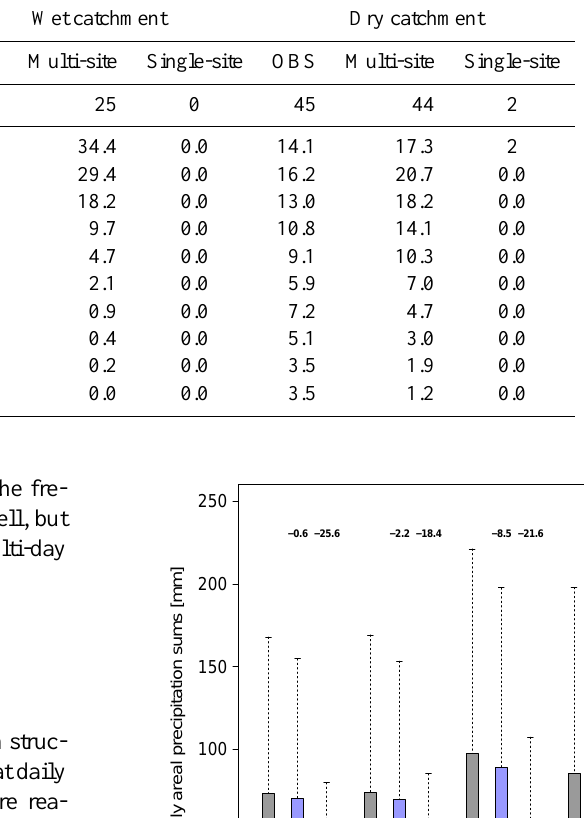
Table 1. Frequencies (given in percent) of a completely wet or dry catchment together with the frequencies of its spell lengths. The observed (OBS) frequencies are calculated over 1961–2011. The multi-site simulated frequencies are given by the mean of 100 runs over 51 years (1961–2011).